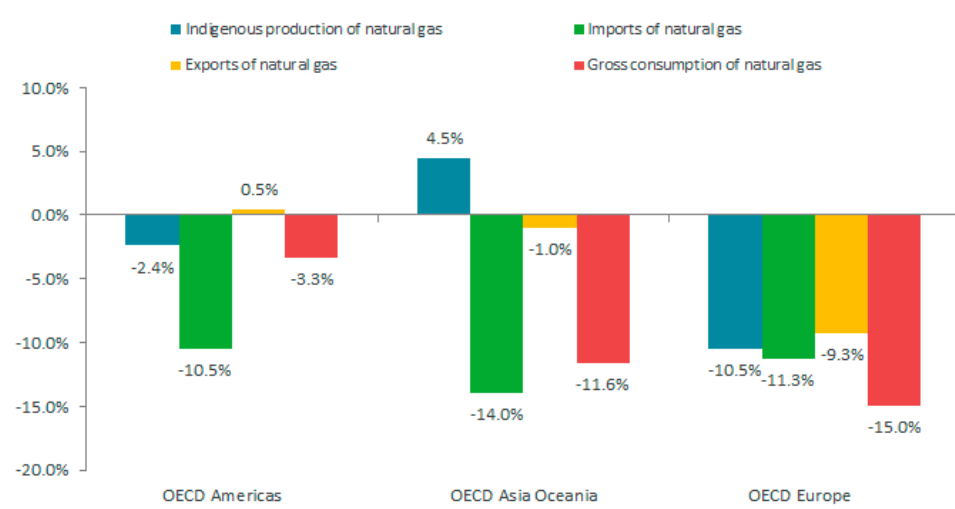
Figure 15. Natural Gas Growth rate per flow and OECD region in April 2020, year on year, IEA Natural Gas Statistics [100].